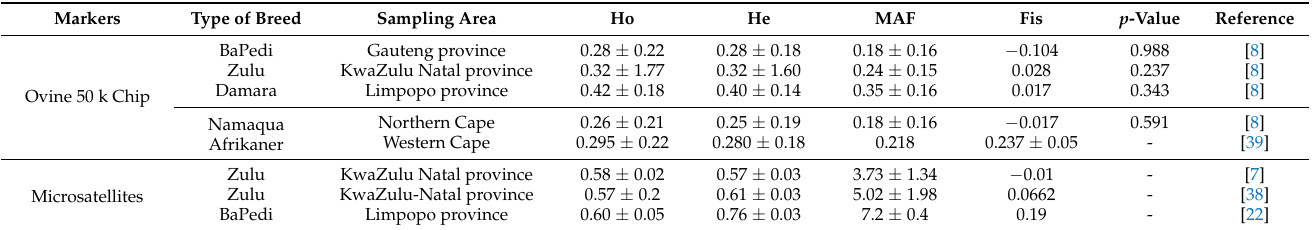
Table 4. Genetic diversity of South African indigenous sheep breeds characterized using Ovine 50 k Chip and Microsatellites